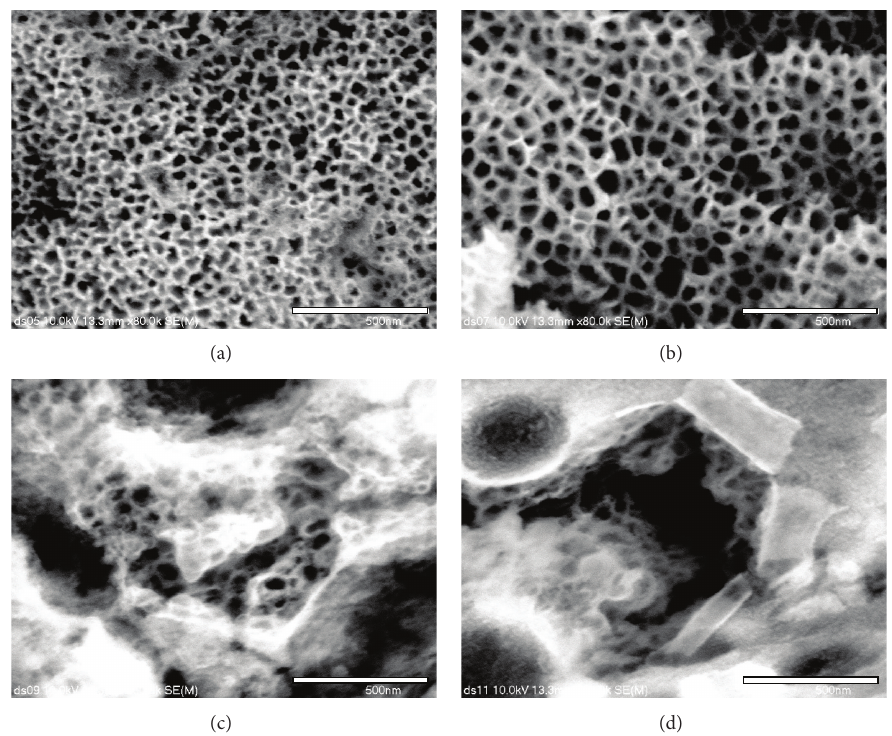
Figure 10: FE-SEM images of anodic tin oxides after 5 min of anodizing of Sn wire in 0.3 M oxalic acid at 5 V (a), 7 V (b), 9 V (c), and 11V